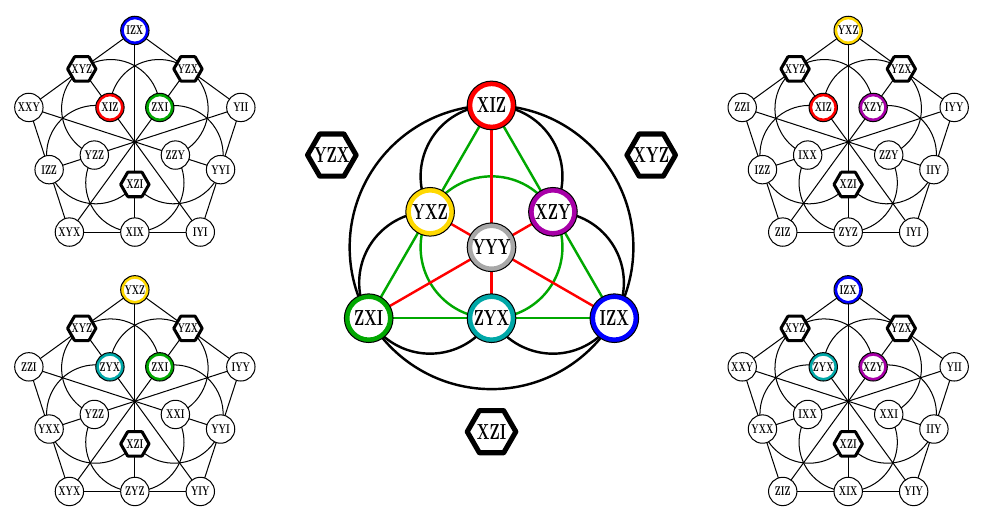
Figure 6. Four three-qubit doilies on a ‘planar’ tricentric triad (represented by hexagons). The seven observables commuting with the three hexagonal ones are, for better illustration, colored differently. The three red lines of the Fano plane that meet at the distinguished observable (gray) are totally isotropic, whilst the remaining four (depicted green) are not. The four complementary triads (of observables) are illustrated by a full black circle and three half-circles.